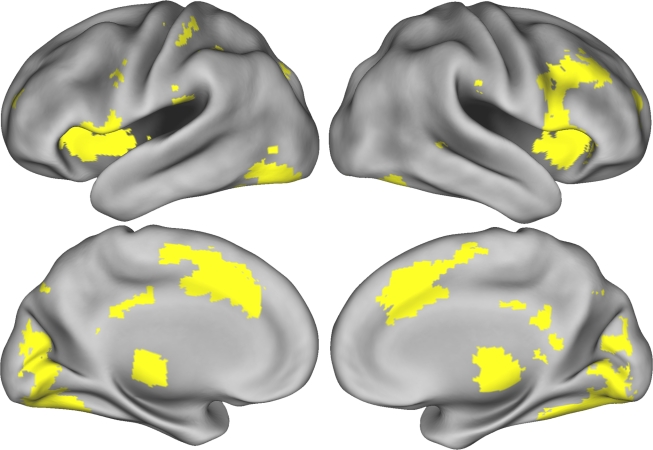
Cortical regions that showed significant RT-related activation in all five samples.Clockwise from top left: ,left lateral, right lateral, left medial, and right medial views of the cortical surface.